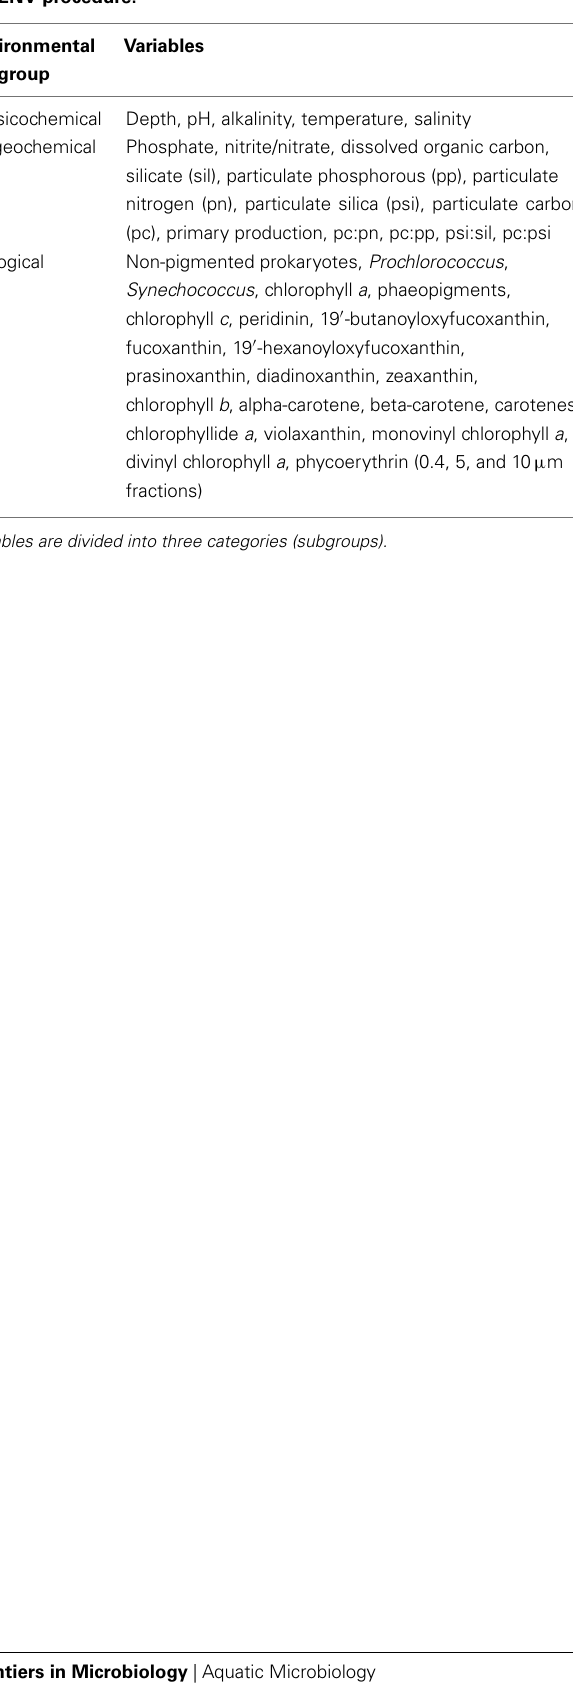
TableA2 | Complete list of environmental variables used in the BIOENV procedure.